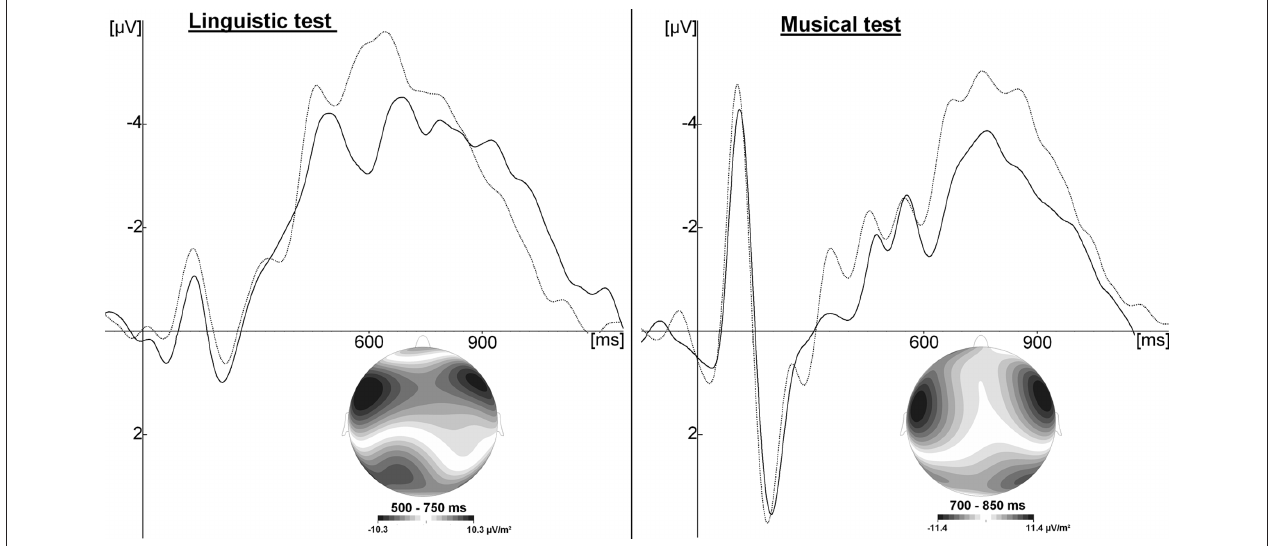
Figure 4 | grand average across two experiments (Francois and Schön, 2010, 2011; N = 50), for the linguistic (left), and musical test (right) at Cz electrode. Solid lines illustrate ERPs to familiar words/tone-words; dashed lines illustrate ERPs to unfamiliar part-words/tone-part-words. Current Source Density Maps illustrate the topographic distribution of the familiarity effect in the significant